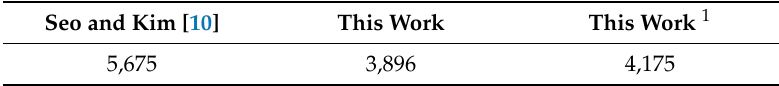
Table 5. Comparison of execution timing (in terms of clock cycles) for 128-bit wise polynomial multiplication. 1 : register optimized version.